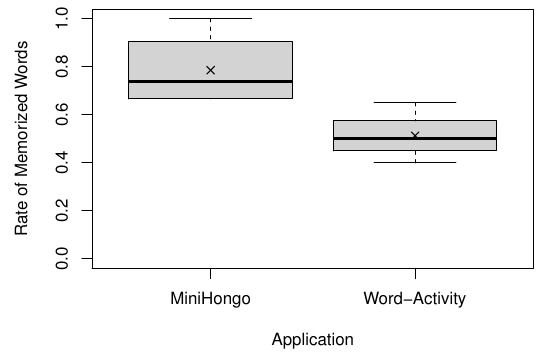
Figure 11. Rate of memorized words among learned